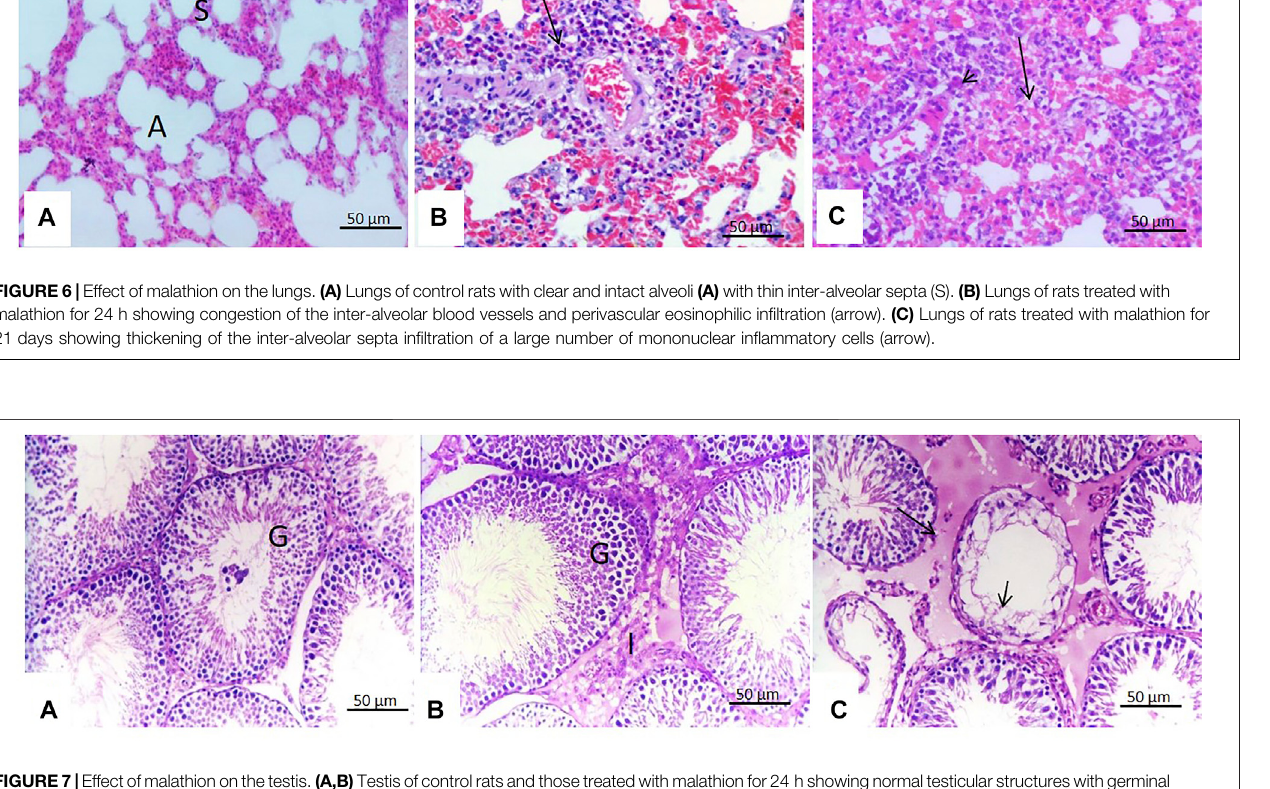
Frontiers in Environmental Science |